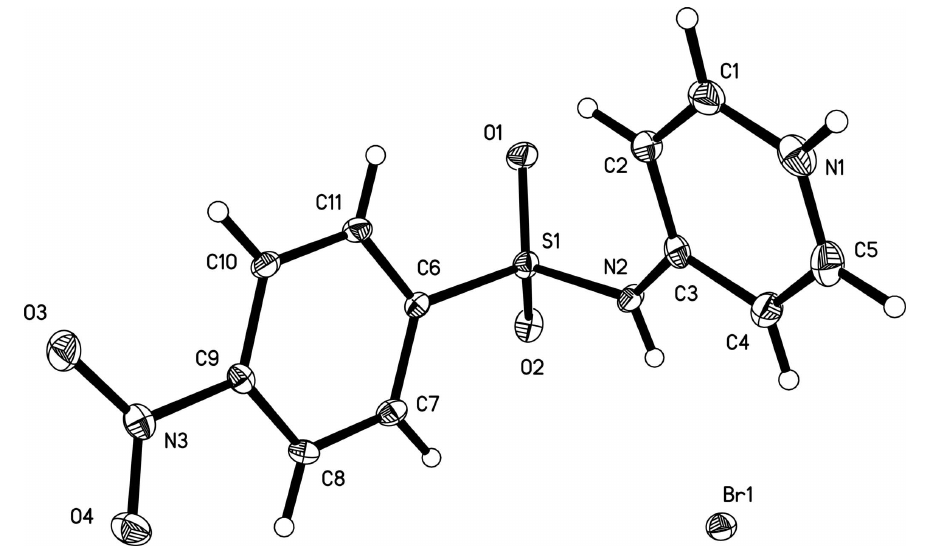
View of one molecule of the title compound showing the atom-labelling scheme. Displacement ellipsoids are drawn at the 35% probability level (arbitrary spheres for the H